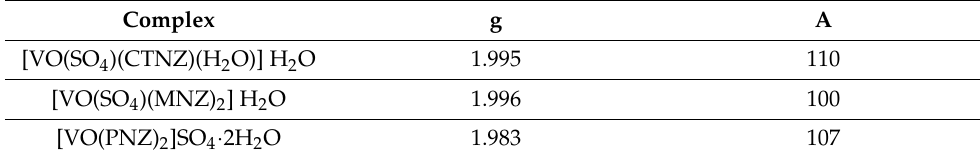
Table 6. EPR parameters of oxidovanadium(IV) complexes.